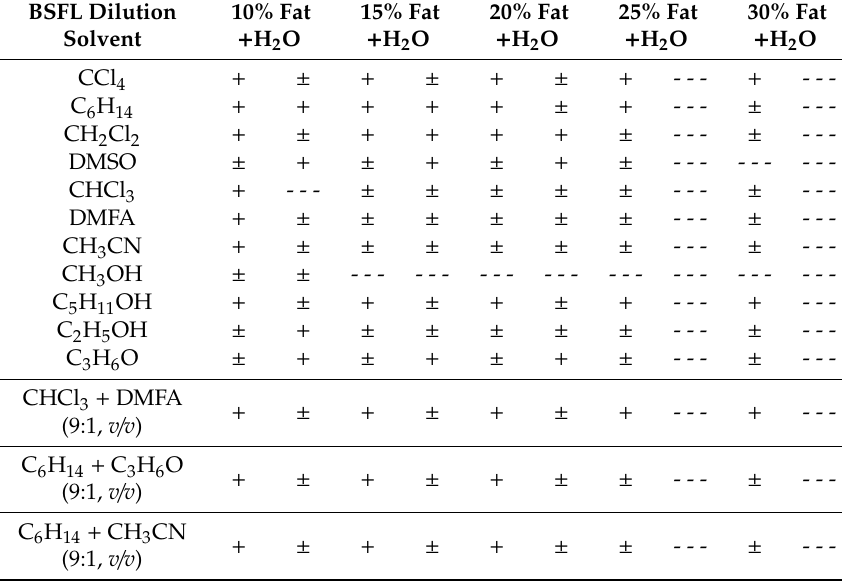
Table 1. Assessment of BSFL fat solubility. BSFL fat solubilized in various single organic solvents or a combination of two. To increase hydrophilicity, the organic reagents diluted in 10-fold with H2O. The solubility of BSFL fat tested in the range 10% to 30% concentration. Solubility marks: ( + ) soluble; ( ± ) partially soluble; (- - -)